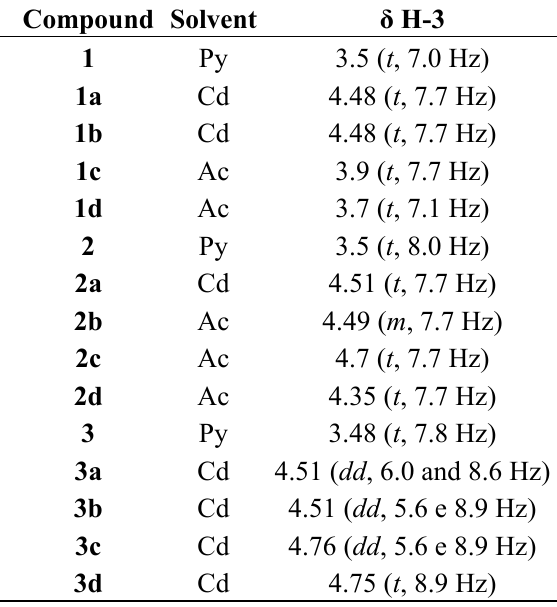
Table 1. H-3 1 H-NMR data for betulinic, oleanolic and ursolic acids and their ester derivatives [300 MHz,  (ppm) J (Hz)].